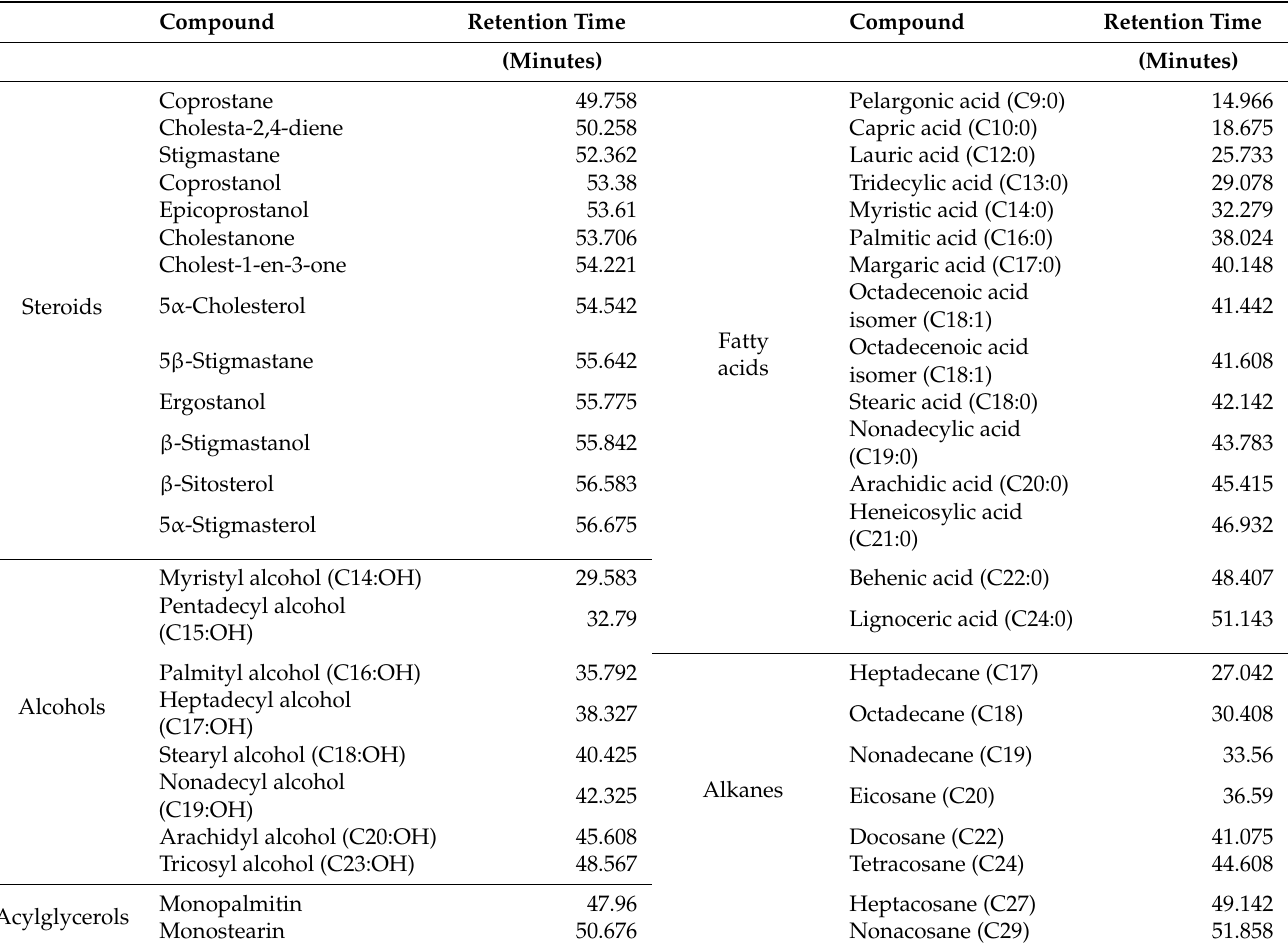
Table 1. List of identified organic compounds from organic sample recovered from Rossio